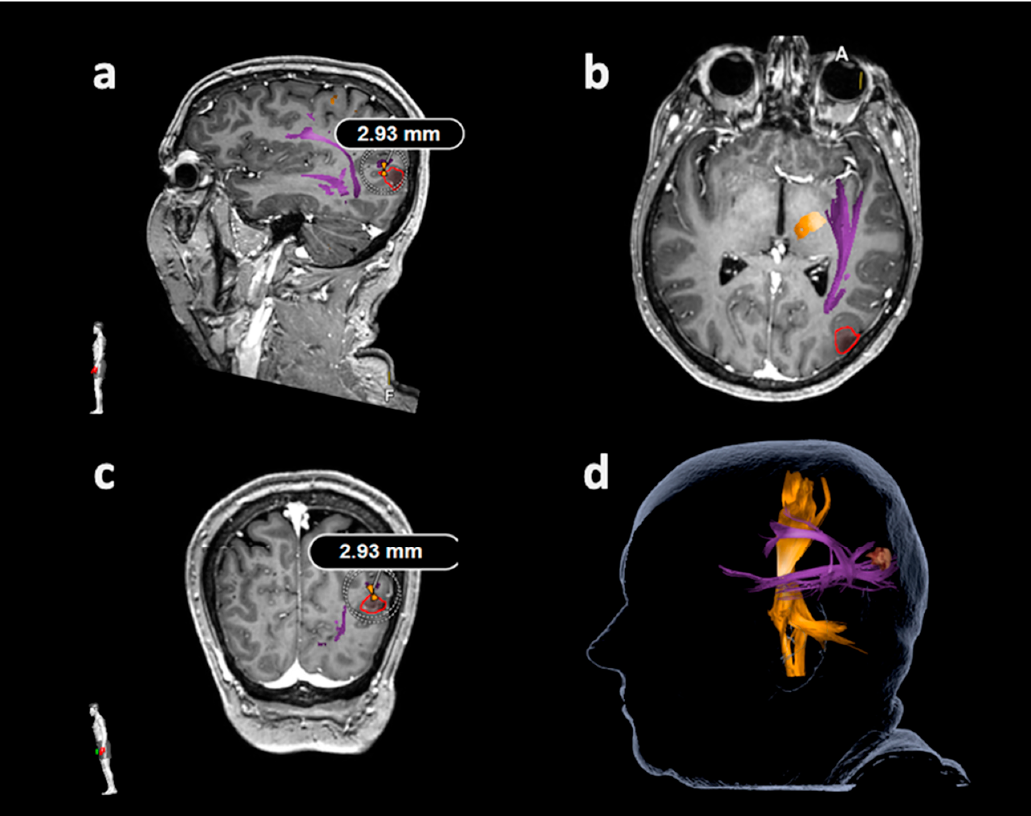
Figure 4. Measurement of the lesion-to-tract distance (LTD) in relation to the frontooccipital fascicle (FoF). This illustrative patient case illustrates the LTD measurement in relation to the FoF as the closest language-related tract except for the arcuate fascicle (AF), applying diffusion tensor imaging fiber tracking (DTI FT) based on the language map derived from navigated transcranial magnetic stimulation (nTMS). The FoF and AF are depicted in purple, the corticospinal tract is shown in orange, and the tumor volume is enclosed in red. During LTD measurements, all planes were considered (( a ): sagittal plane, ( b ): axial plane, ( c ): coronal plane), with the LTD measurement of 2.93 mm being shown in parts ( a ) and ( c ) in this patient case. The three-dimensional (3D) head model including the structures of interest is provided in part ( d ).